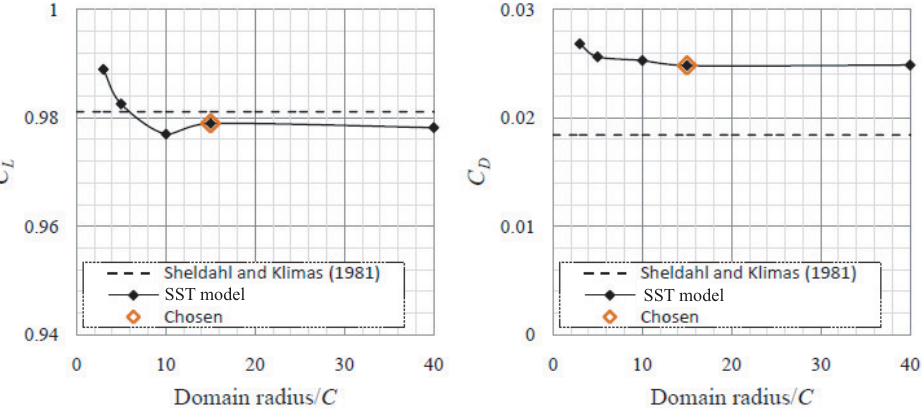
Figure 8. Variation in lift and drag as a function of domain radius ( α = 10 ◦ , Re = 3.6 × 10 5